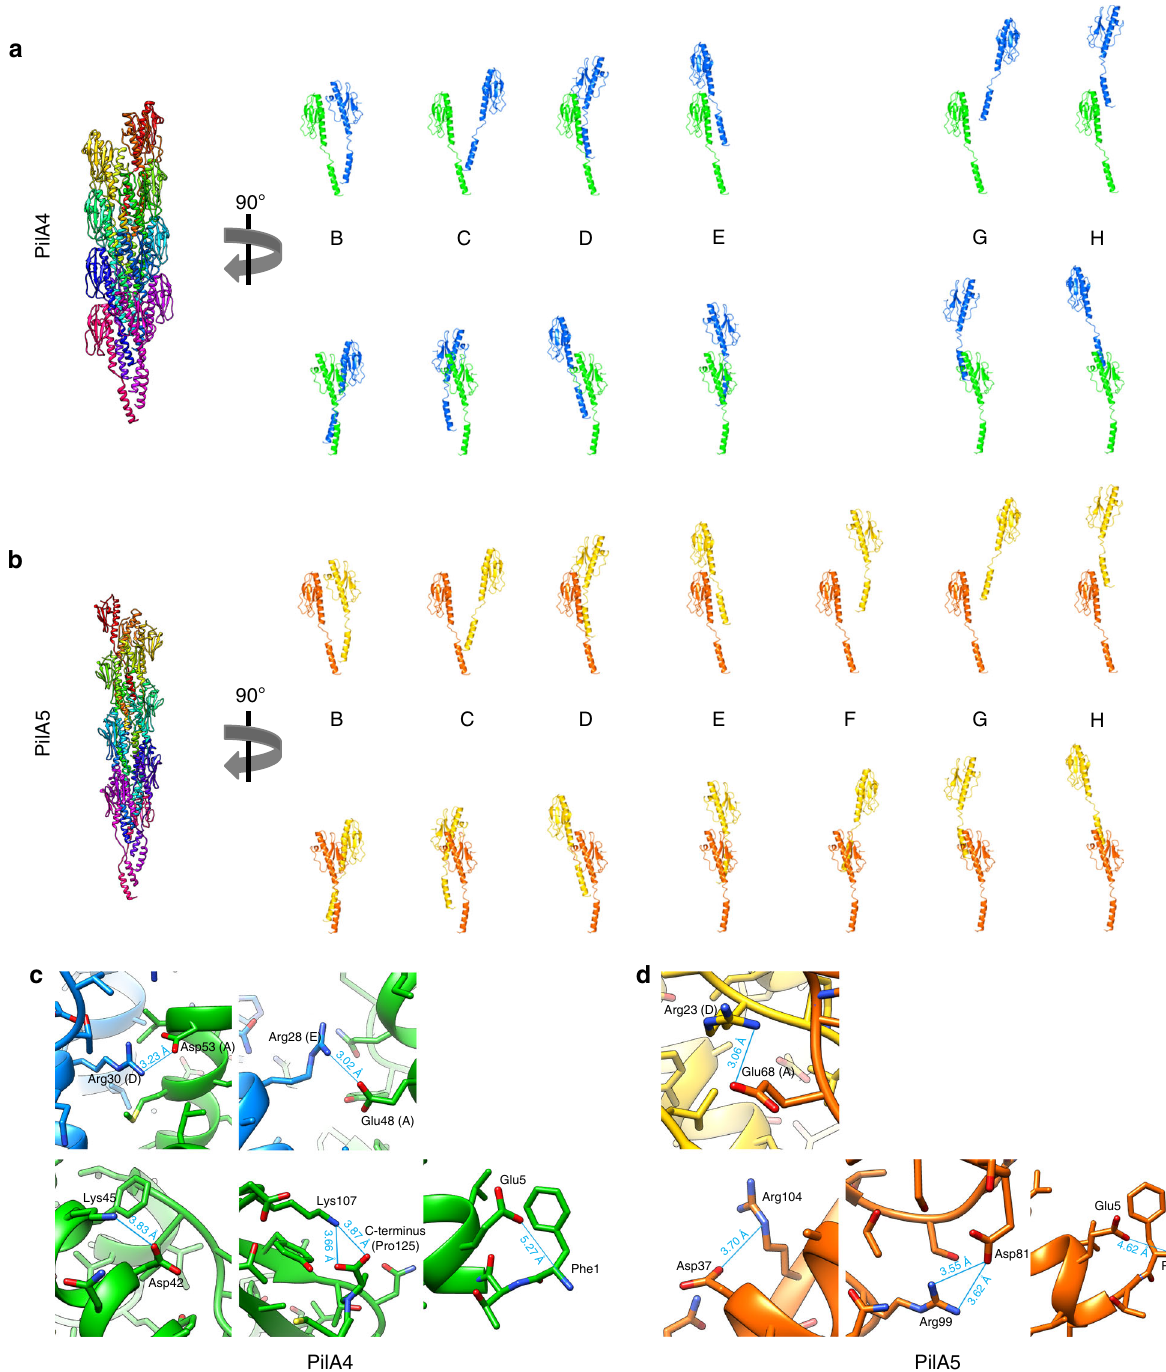
Fig. 4 Intra and intermolecular interactions. a Ribbon representation of a 15-mer wide fi lament (left) and pairs of interacting subunits. Subunit A (green) is shown with other single subunits within the fi lament (blue) from B ( + 1) to H ( + 7). Subunit F ( + 5) is not shown because it does not interact with subunit A. b Ribbon representation of a 15-mer narrow fi lament (left) and pairs of interacting subunits. Subunit A (orange) is shown with other single subunits within the fi lament (yellow) from B ( + 1) to H ( + 7). c , d Close-ups of intermolecular (top row, letters in brackets correspond to the subunits shown in a , b ) and intramolecular (bottom row) salt bridges within PilA4 wide ( c ) and PilA5 narrow ( d ) fi laments. Same colour code as in a , b